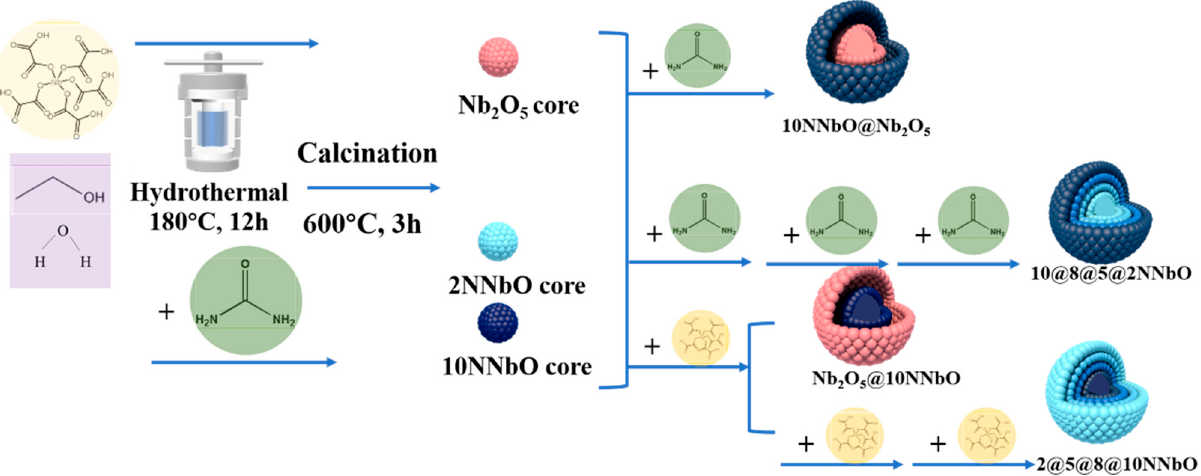
Scheme 1. Schematic illustration for the synthesis of gradient-doped Nb 2 O 5 microspheres with N concentration.